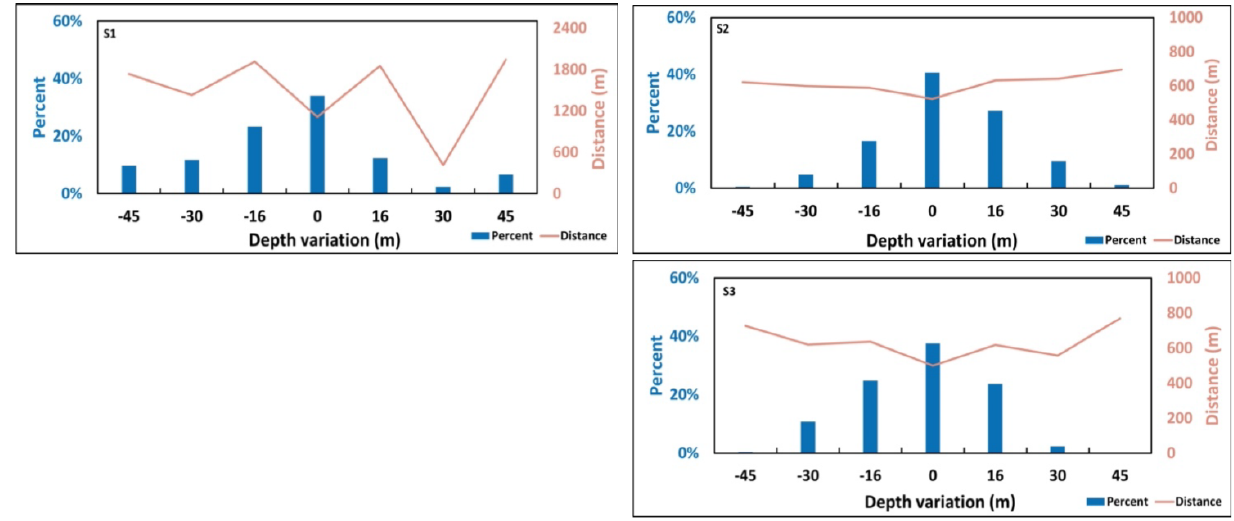
Figure 12. Statistical result of the variations of AA 3c thickness and the corresponding subsatellite distance between the compared node pair in study areas. The horizontal axis presents the thickness change of AA 3c of each pair of subsatellite points, whose distance is less than 3 km. The vertical axis on the left shows the percentage. The vertical axis on the right shows the average distance for each difference.